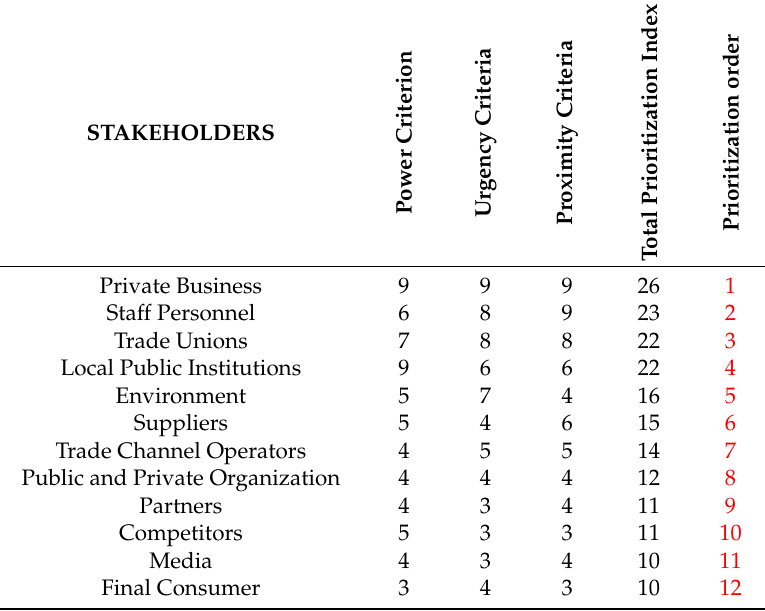
Table 4. Prioritization of stakeholders in a ceramic firm.